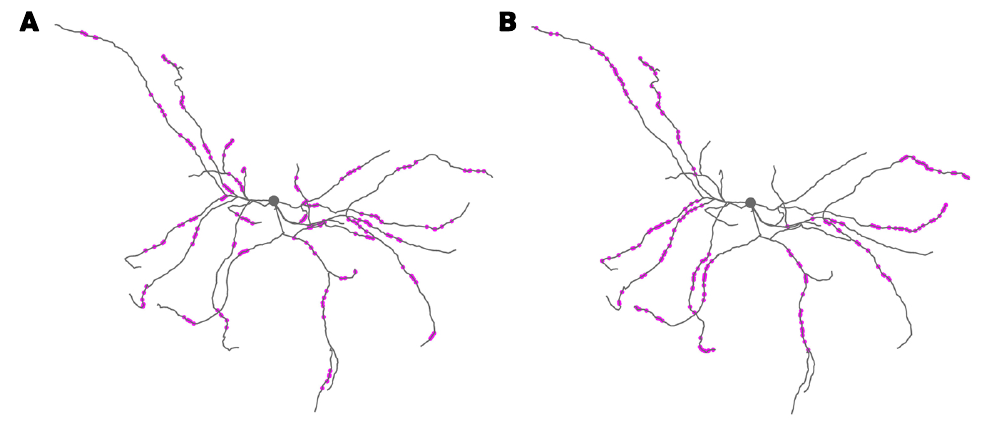
Figure 2. Synapses receiving spike trains with clustered input. ( A ) Spike trains target dense clusters of 5 synapses. ( B ) Spike trains target dispersed clusters of 40